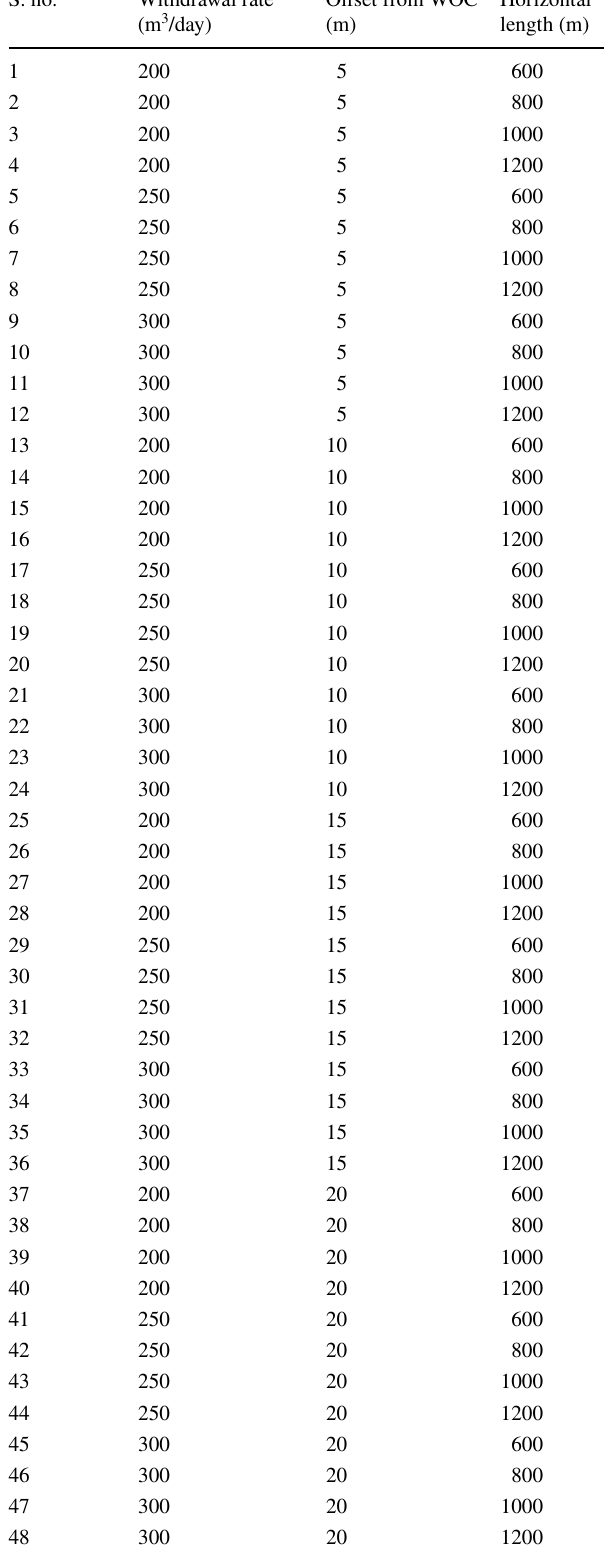
Table 6 List of cases for horizontal well S.